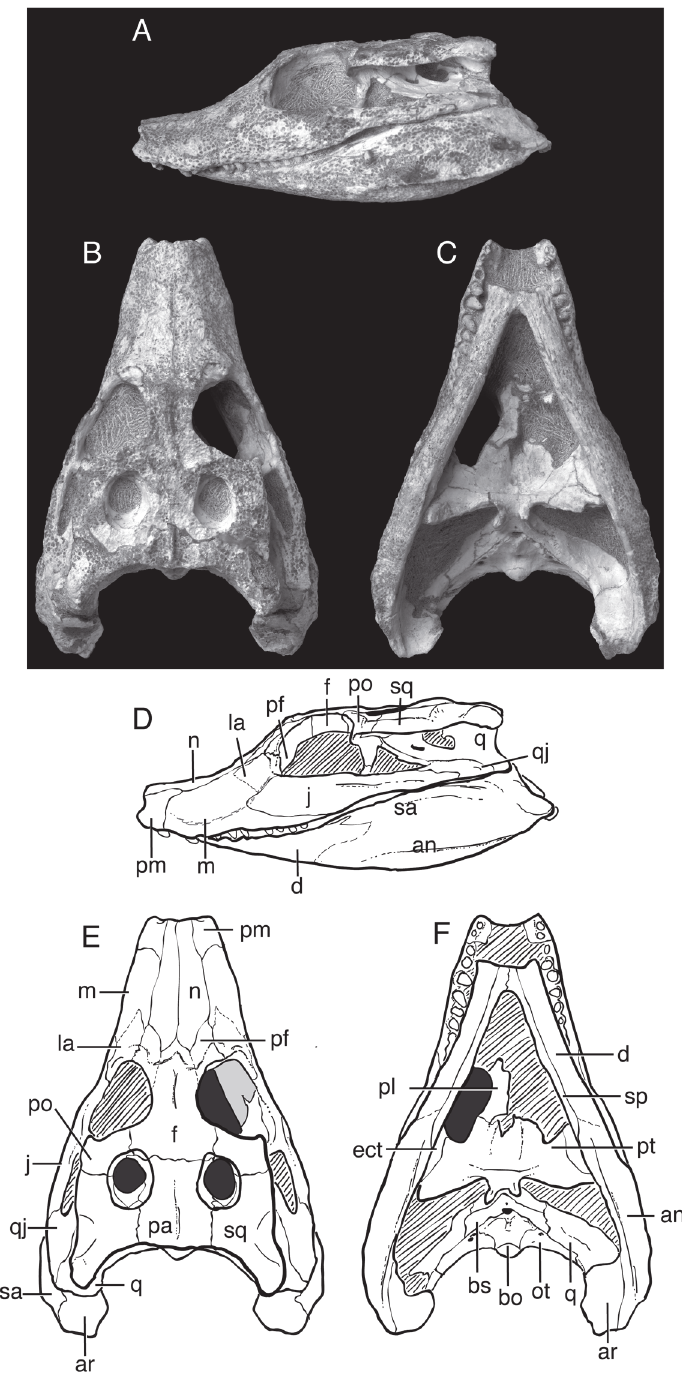
Fig 3. IGM 100/1195, Shamosuchus djadochtaensis , Djadokhta Fm., Campanian, Mongolia. Photographs in A , lateral, B , dorsal, C , ventral views. Line drawings in D , lateral, E , dorsal, F , ventral views. Abbreviations: an, angular; ar, articular; bo, basioccipital; bs, basisphenoid; d, dentary; ect, ectopteryoid; f, frontal; j, jugal; la, lacrimal; m, maxilla; n, nasal; ot, otoccipital; pa, parietal; pf, prefrontal; pl, palatine; pm, premaxilla; po, postorbital; pt, pterygoid; q, quadrate; qj, quadratojugal; sa, surangular; sp, splenial; sq, squamosal.